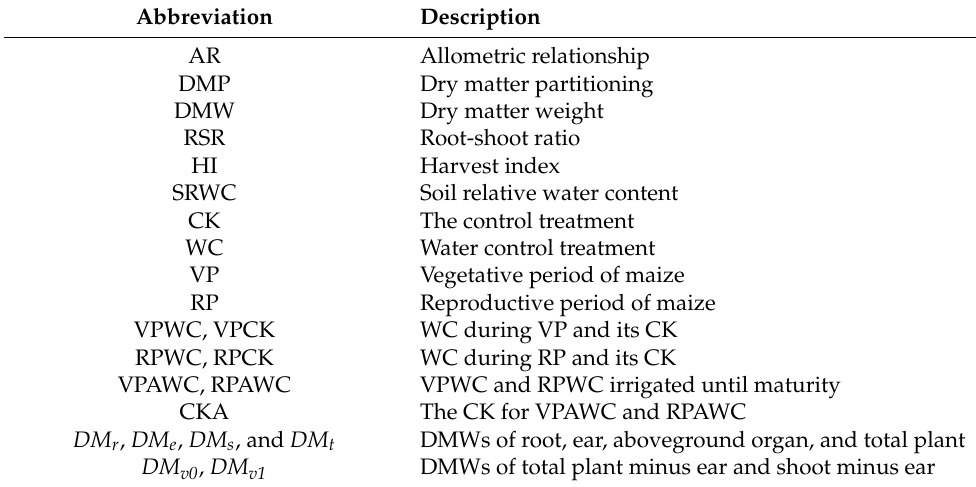
Table 1. Abbreviations used to denote each parameter and